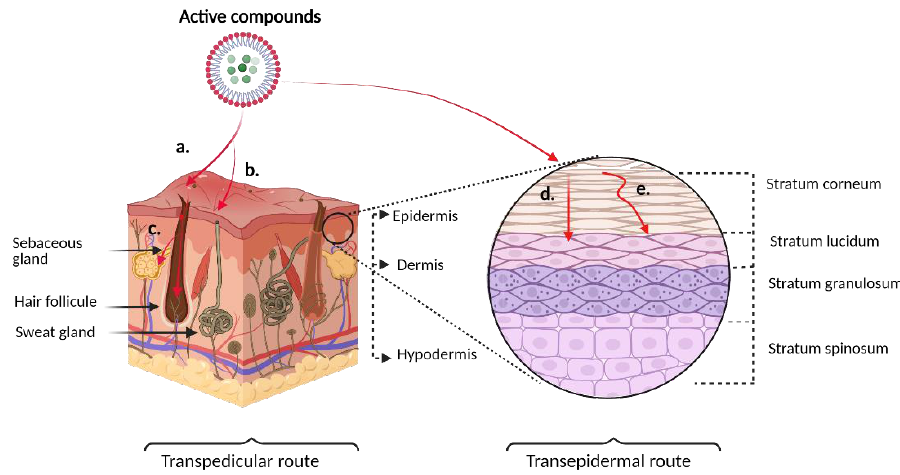
Figure 1. Schematic representation of the routes of skin penetration of active compounds. On the left, a transpedicular route consists of a. entry through hair follicle, b. entry through sweat glands, c. entry through sebaceous glands. On the right, transepidermal route. d. Transcellular pathway, e. Intercellular pathway.